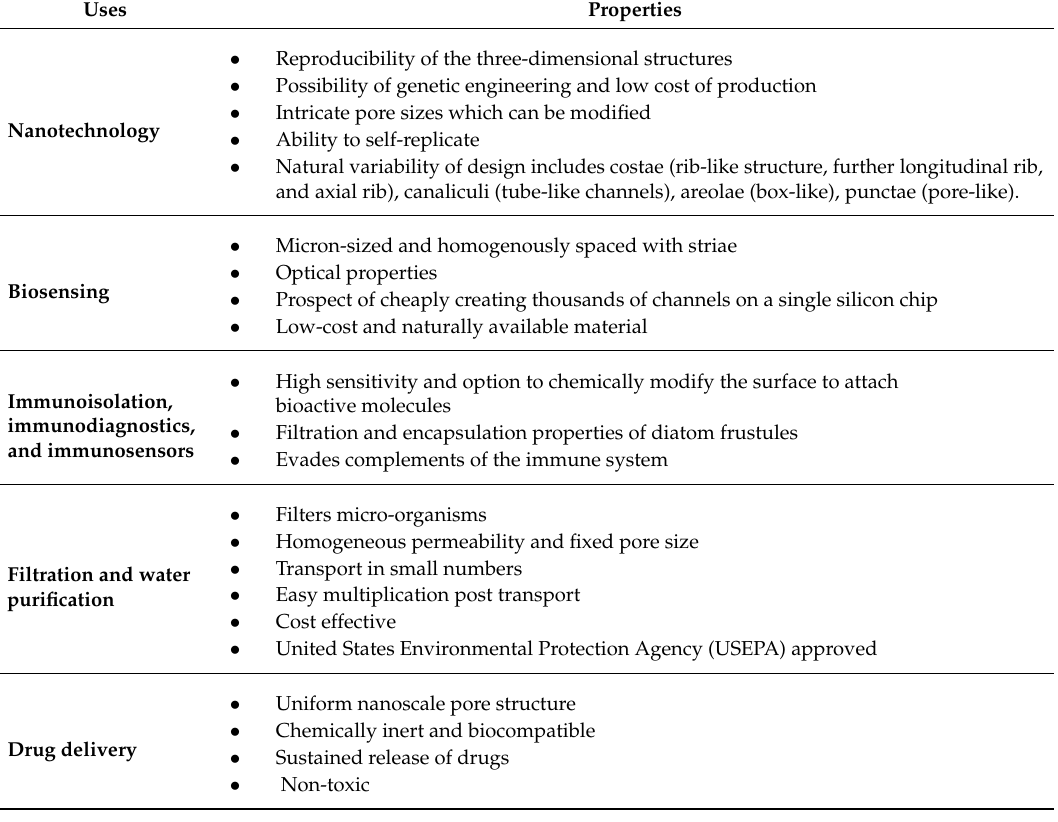
Table 1. Properties of diatom frustules and their application in different